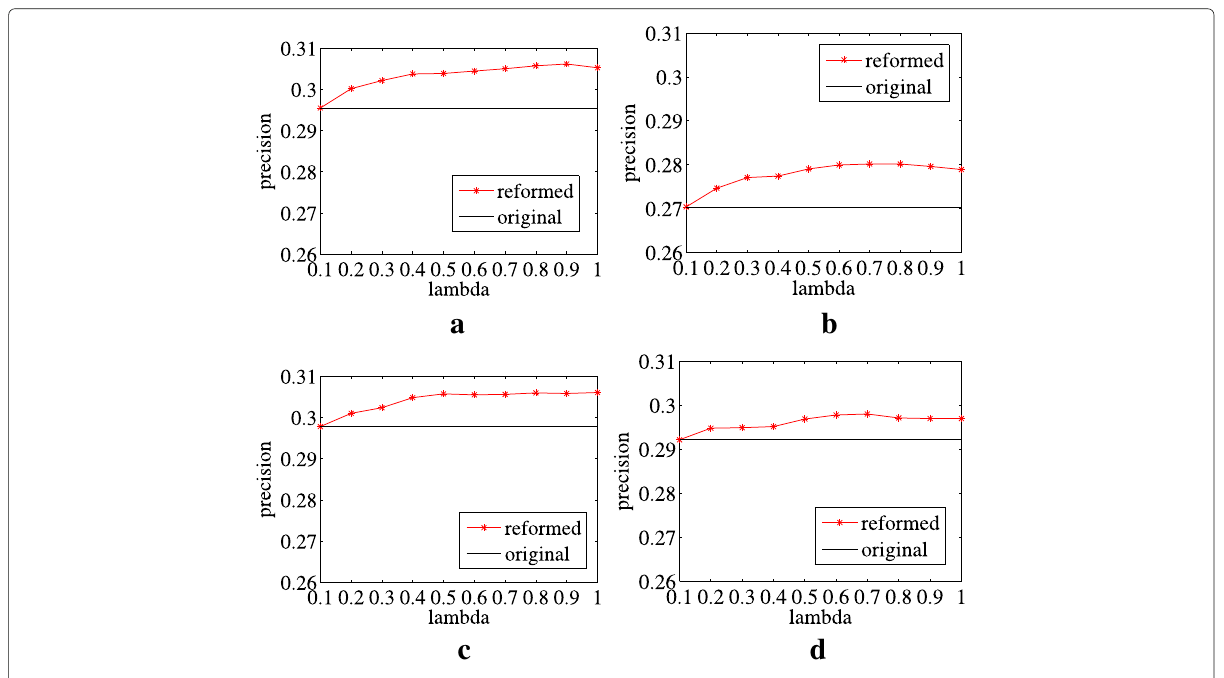
Fig. 4 The precision of the reformed and original distance metrics. a chi2. b L2. c L1. d